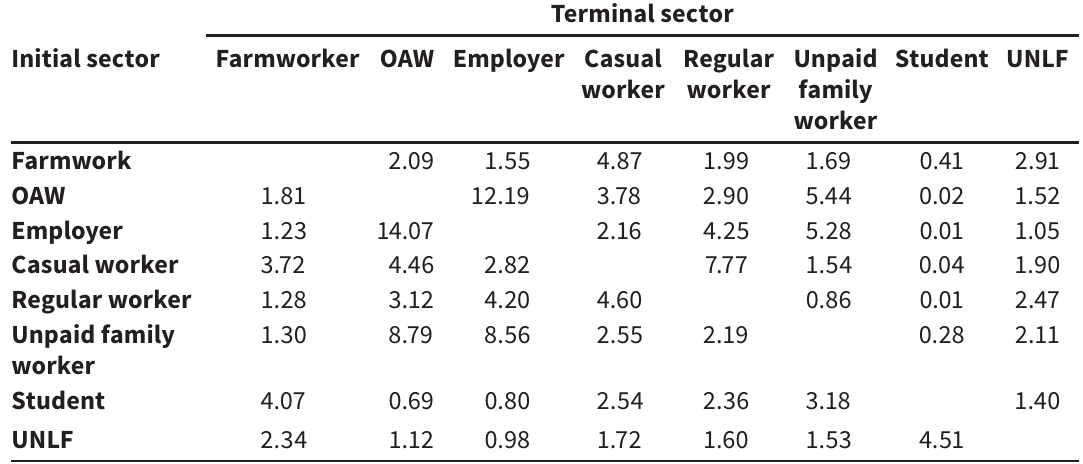
Terminal sector